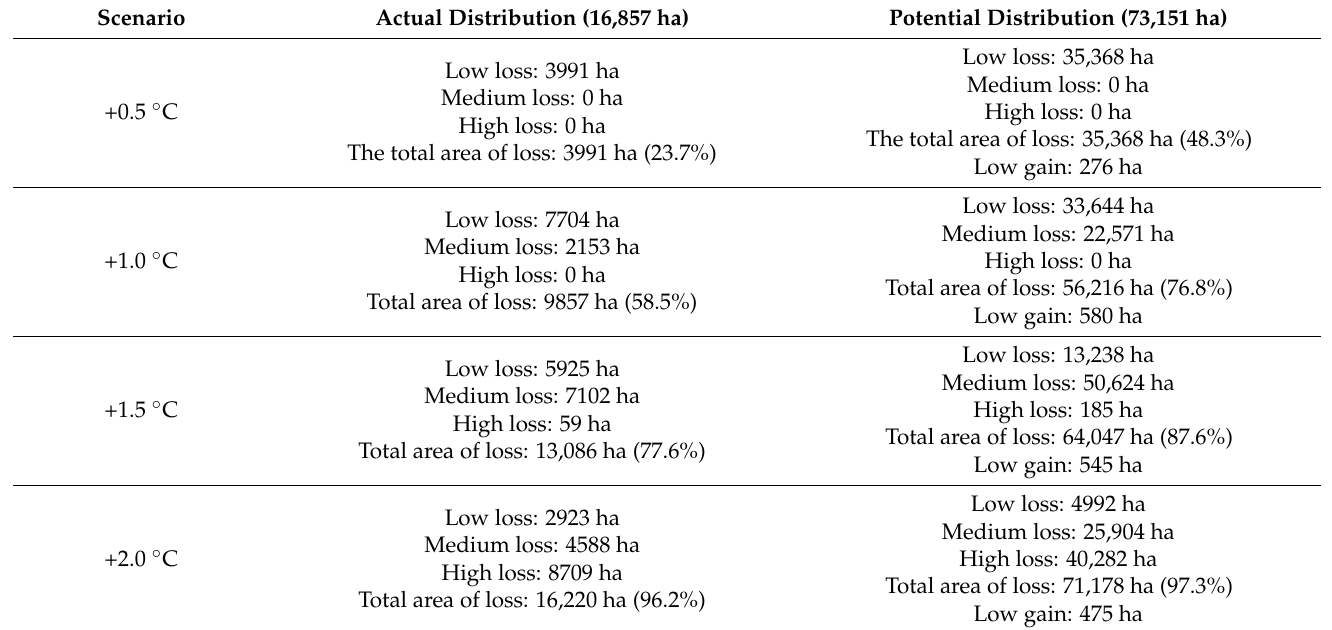
Table 4. Under the +0.5~+2.0 ◦ C warming scenario, the loss and gain of A. kawakamii potential distributions in